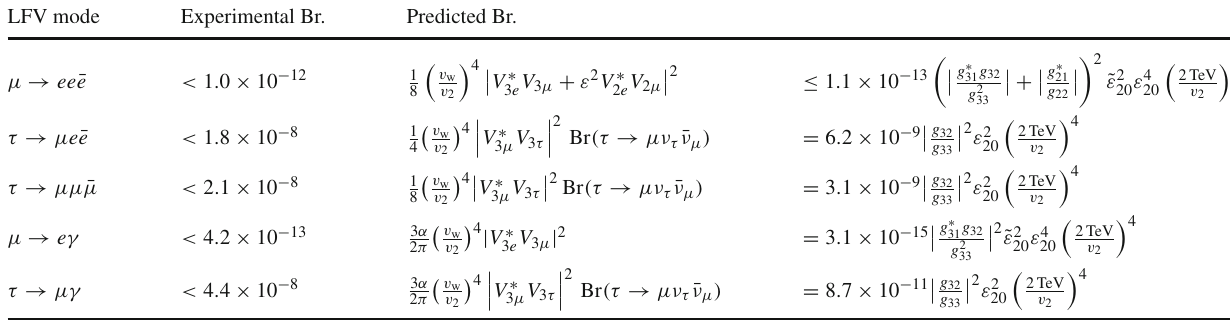
Table 1 Experimental limits on the branching fractions for the LFV decays [37] vs. those predicted in our model. For the LFV decays of τ lepton the branching ratio Br (τ → μν τ ¯ ν μ ) = 0 . 174 is taken into account. In last column we used Eq. (16) for the elements of mixing matrix V R and set the scale v 2 = 2 TeV from the compositeness limits.